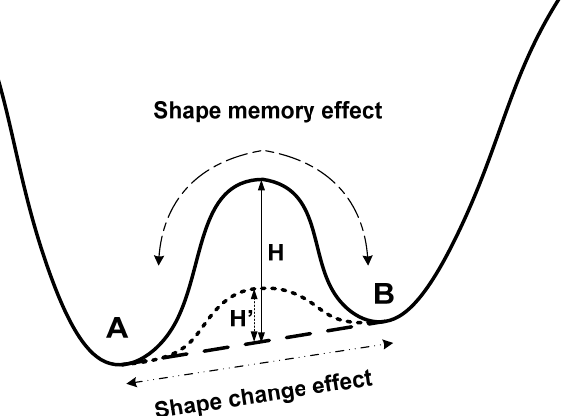
Figure 2. Shape memory effect (SME) and shape change effect (SCE). (Reproduced with permission from [3]. Copyright 2012